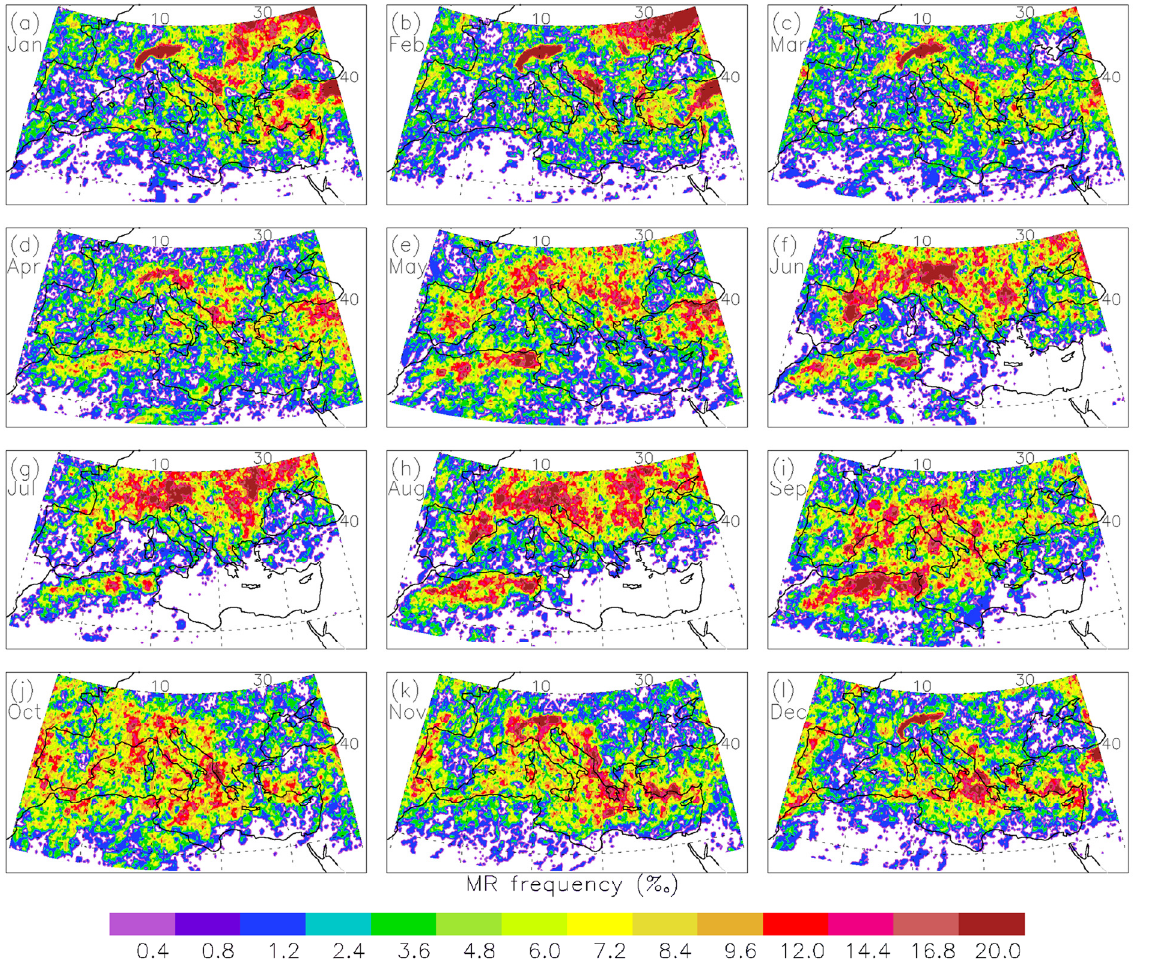
Figure 5. Spatial distribution of monthly climatology of MR frequency over the Mediterranean region from January 2000 through December 2007 from NOAA-15